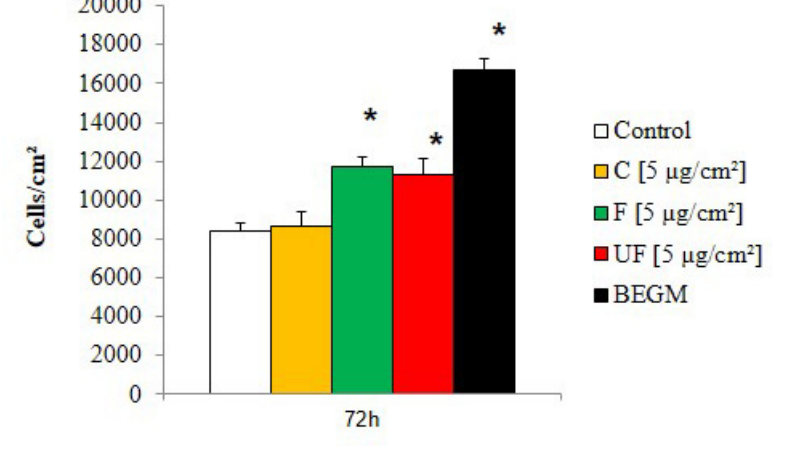
Figure 5. Effect of conditioned media on fibroblast (Wi-38) proliferation. Cells were exposed for 72 hours to conditioned medium from control HBE cells or HBE cells exposed four times (48 hours between treatments) to coarse (C), fine (F) and ultrafine (UF) PM at 5 µg/cm², or to fresh BEGM medium. *: Different from the control ( p < 0.05), n =